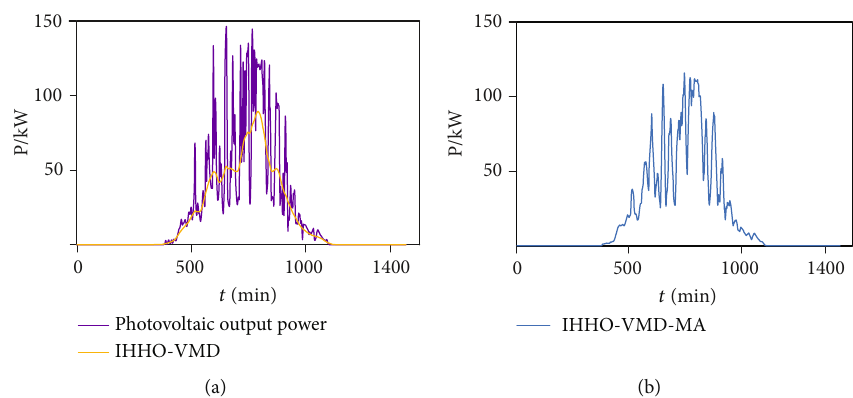
Figure 10: Comparison of PV output power. (a) Grid-connected power with correlated mode. (b) Method of grid-connected power.